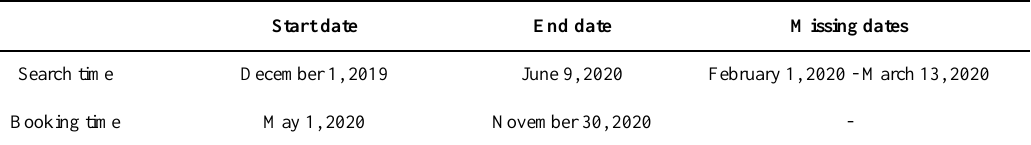
Table 2. Definition of periods of